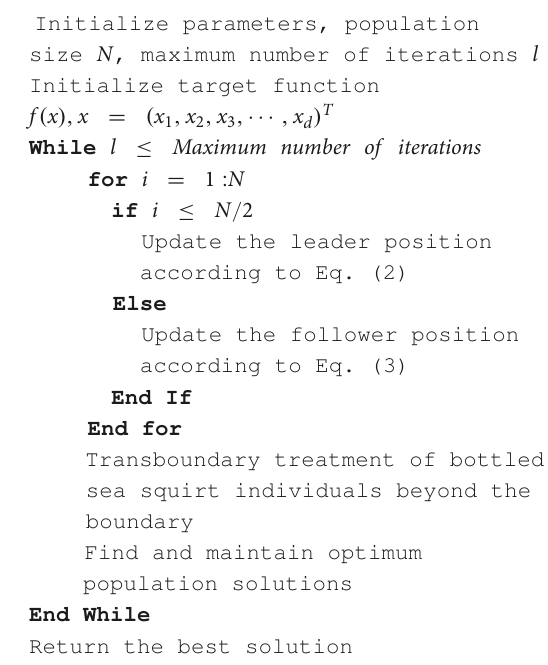
Algorithm 1. Pseudo-code of CS.